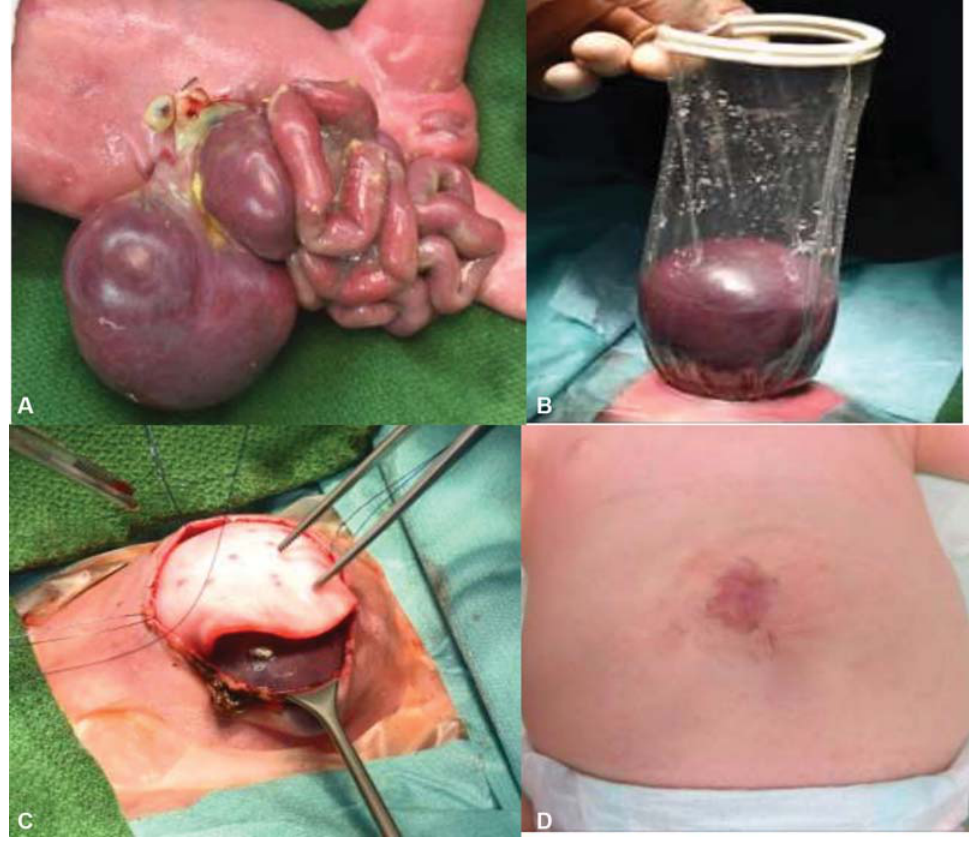
Fig.1 Giant gastroschisis ( A ) after delivery,( B ) after positioning of the wound retractor under thefascia, ( C ) secondaryclosure of theabdominal cavity using a bovine xenograft on day of life 10, and ( D ) follow-up at the age of 14